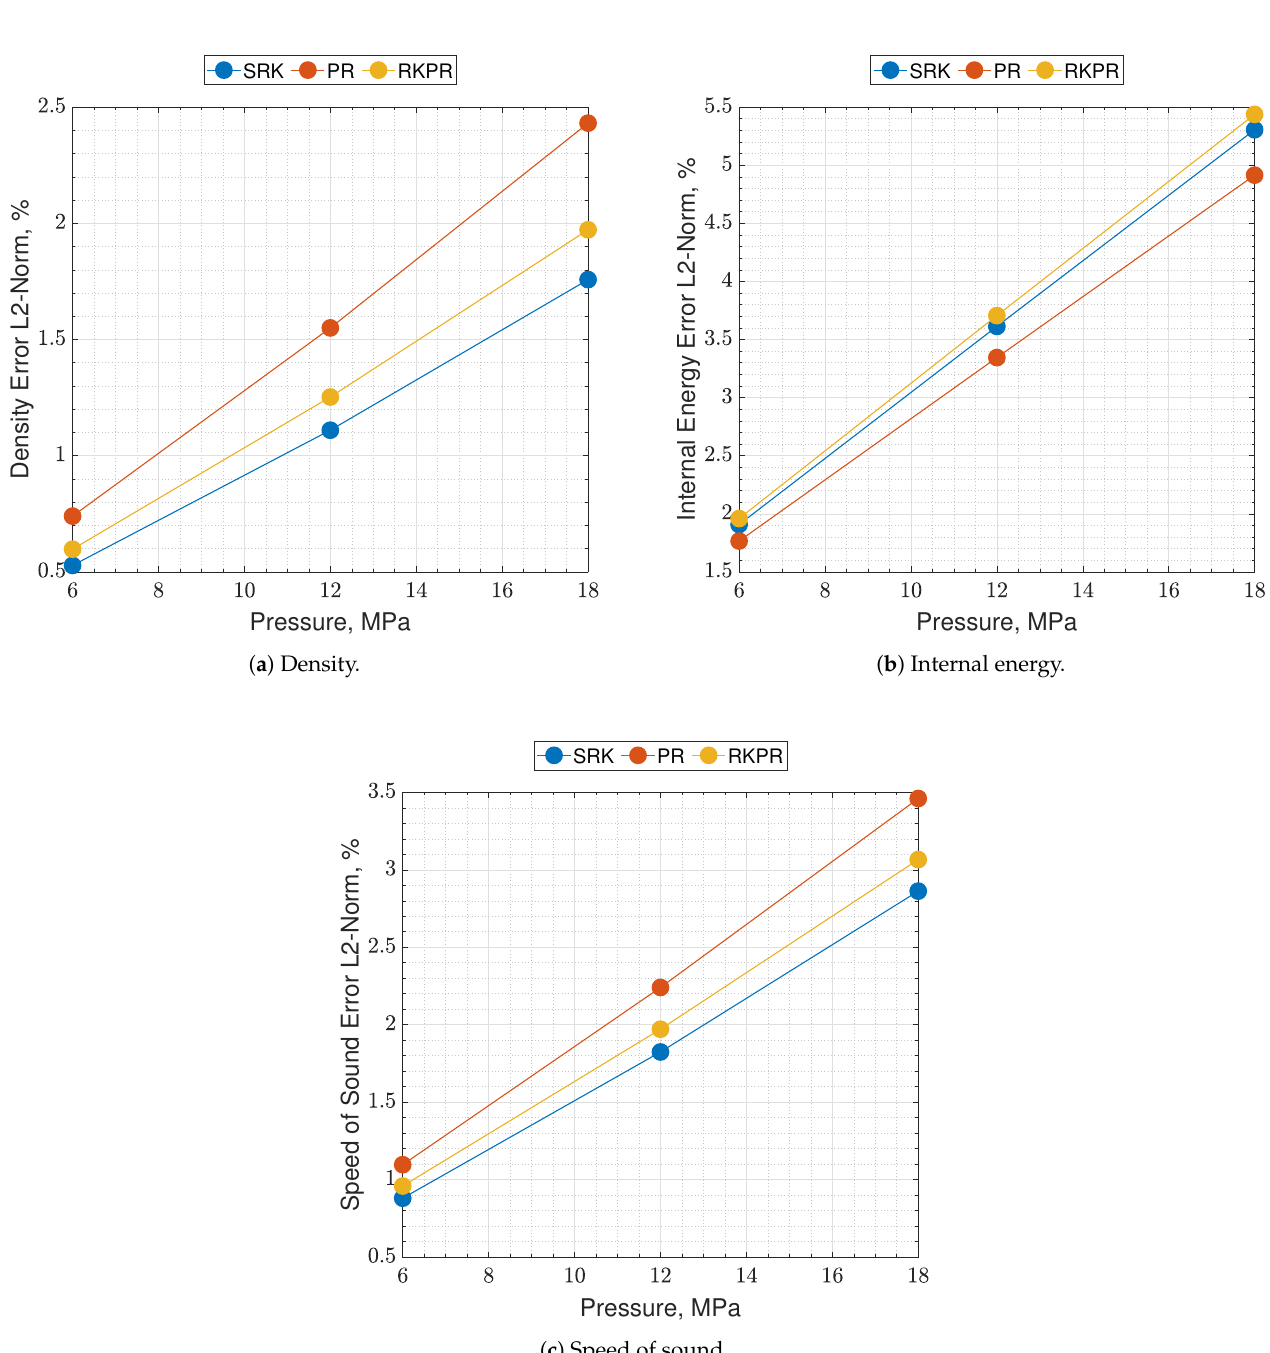
Figure 5. Percent errors of the present EoS in its SRK, PR and RK-PR operative modes with respect to refprop data. Mixture is O 2 - CH 4 with O/F = 3.4. Errors are estimated as the nondimensionalized L2-norms calculated between the EoS results and the NIST dataset over the whole temperature range for a single pressure